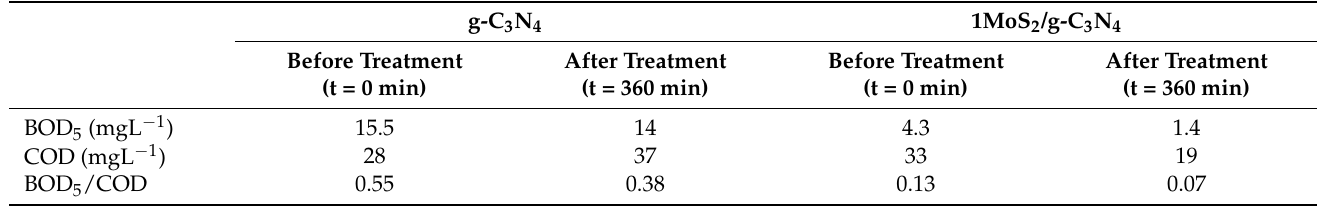
Table 3. BOD 5 (mgL − 1 ), COD (mgL − 1 ), and BOD 5 /COD measured in secondary effluent of hospital WWTP before and after photocatalytic